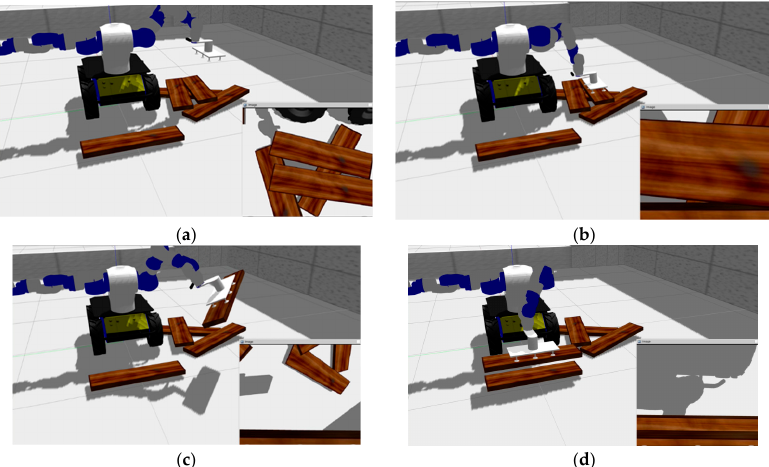
Figure 20. The result of the robot visually grasping wooden planks: ( a ) Identifying the pose of the plank to be grasped; ( b ) positioning the end of the robot and grasping; ( c ) during the robot handling process; ( d ) preparing to place the grasped wooden plank.